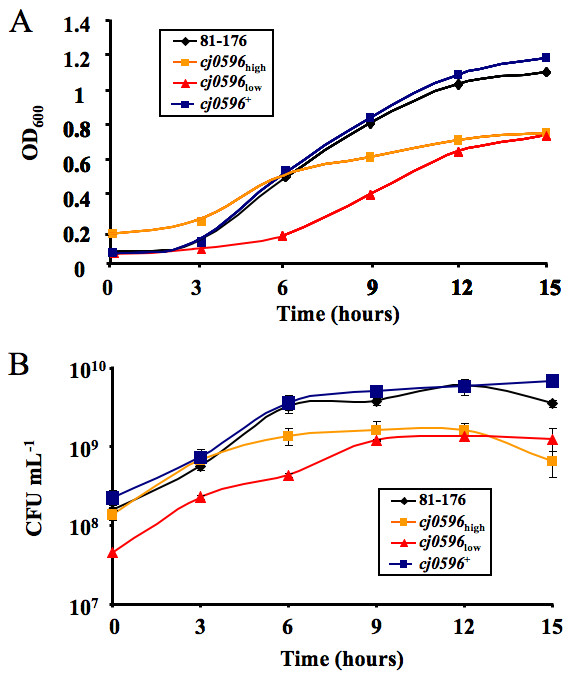
Growth of C. jejuni strains at 37°C in MH broth. Strains 81–176 (black diamonds), 81–176cj0596 ("low" inoculum, red triangles) and 81–176cj0596+ (blue squares) were inoculated at an OD600 of ~0.06 and growth was monitored by OD600 (A) as well as CFU mL-1 (B). Additionally, 81–176cj0596 ("high" inoculum, orange squares) was inoculated at an OD600 of ~0.2.